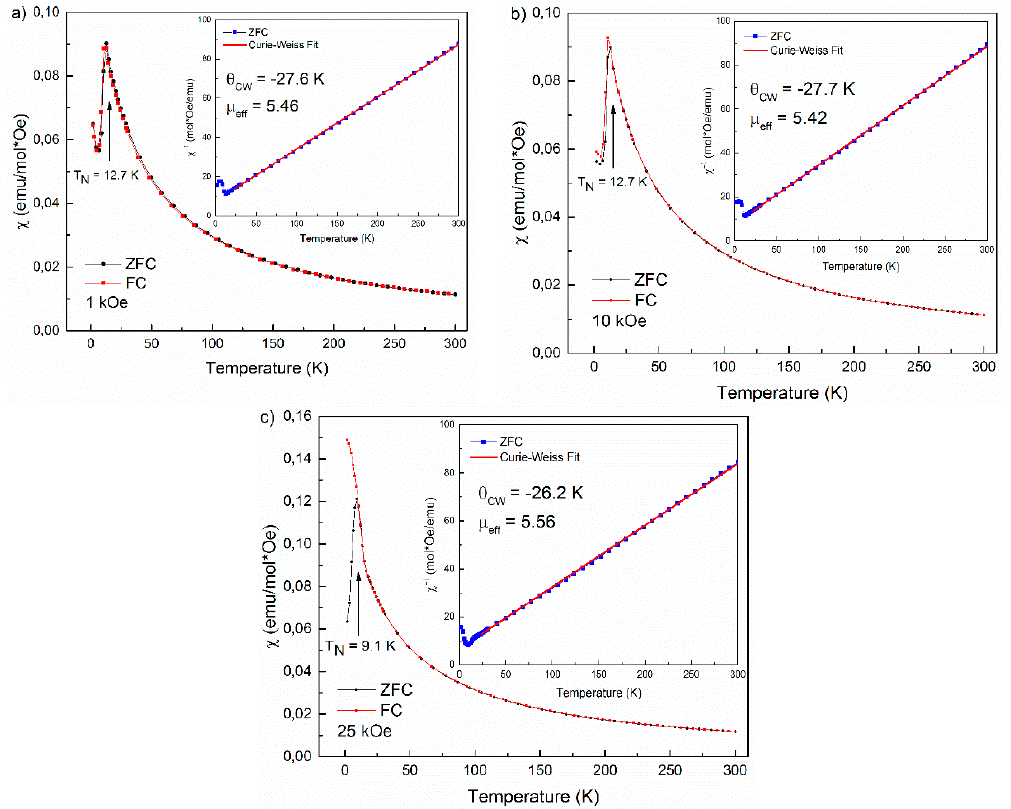
Figure 8. Magnetic susceptibility as a function of the temperature at zero-field-cooled/field-cooled (ZFC/FC) conditions under constant applied fields of: ( a ) 1 kOe; ( b ) 10 kOe; and ( c ) 25 kOe for LCP- Cmcm produced by polyol method. The inset shows the inverse magnetic susceptibility and the Curie-Weiss fitting of the high temperature data under ZFC conditions.